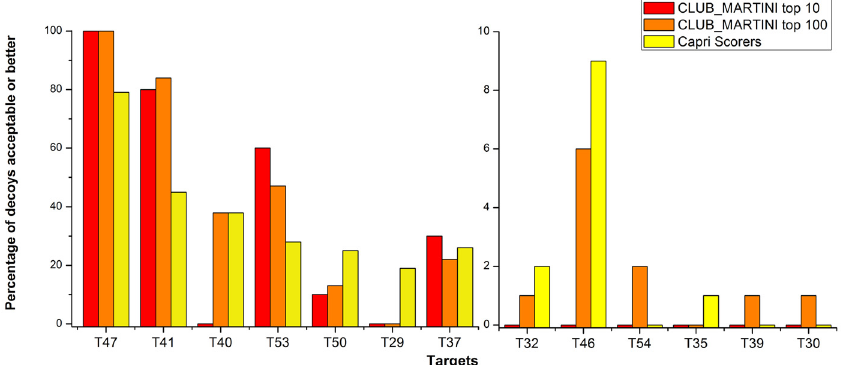
Fig 5. Comparison with overall performance of ‘ scorers ’ in CAPRI experiments. There are three bars for each target: red for CLUB-MARTINI Top_10, orange for CLUB-MARTINI Top_100 and yellow for CAPRI ‘ Scorers ’ . We consider our Top_100 performance significantly better for five targets: T41, T53, T54, T39 and T30 (higher than 1.5 fold relative to CAPRI Scorers); and similar for four more: T47, T40, T37 and T46 (0.67 to 1.5 fold). The ordering of the targets is the same as in Fig 3 (hardest on the